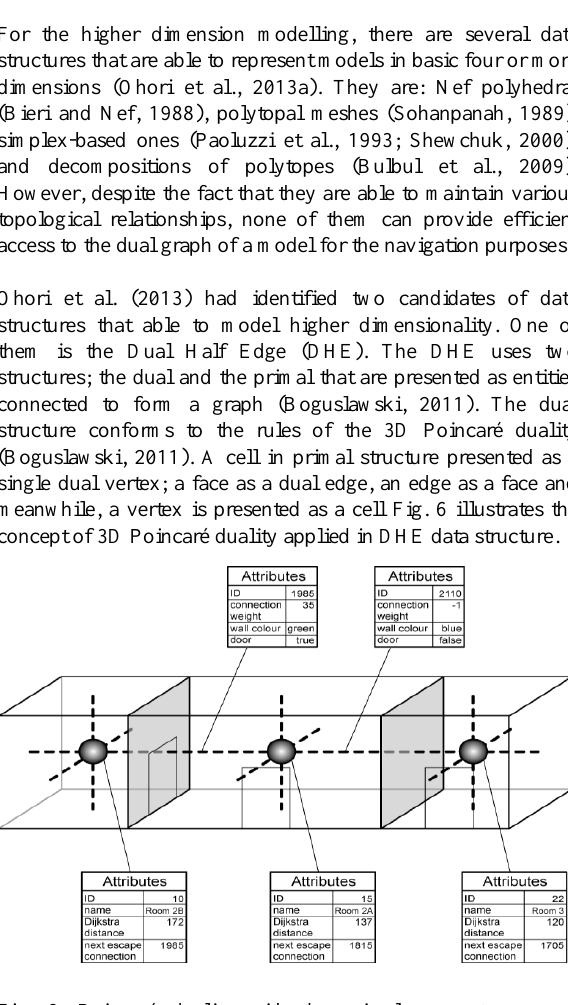
from half edge to half edge, each half edge consist of directed half edge with dual half edge. There are four basic set of operator pointers available for navigation; Sym, Nextv, nextf , and the dual for every primitives such in Fig.